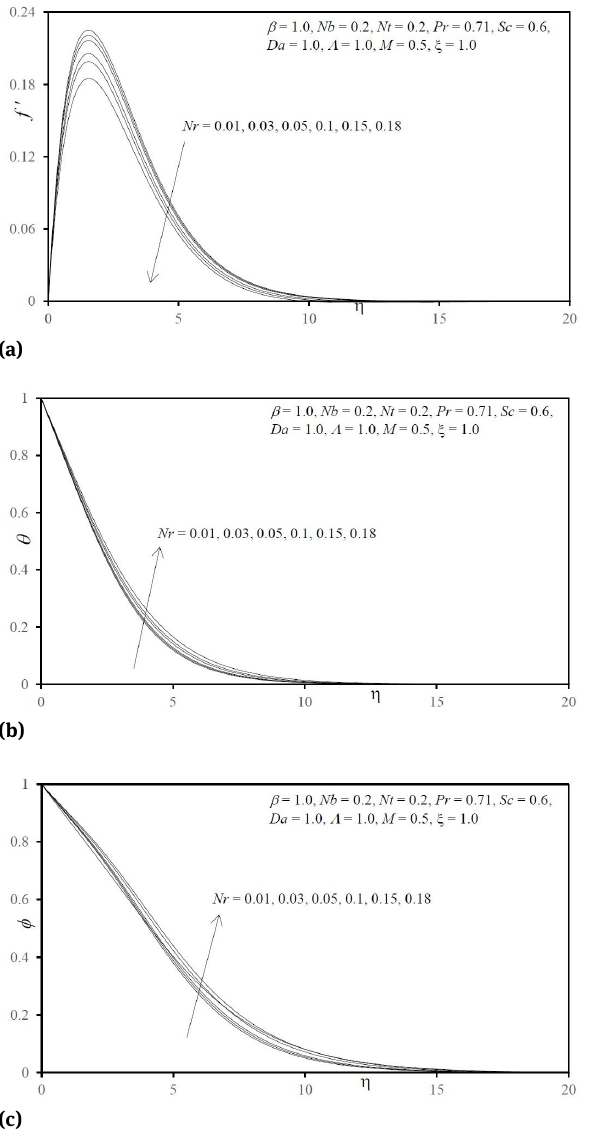
Fig. 6: (a) Influence of Nr on Velocity Profiles; (b) Influence of Nr on Temperature Profiles; (c) Influence of Nr on Concentration Profiles larger than that for the thermal diffusion of the base liquid.